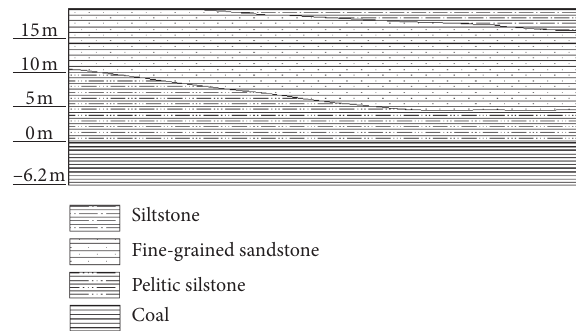
Figure 13: Stratigraphic change.